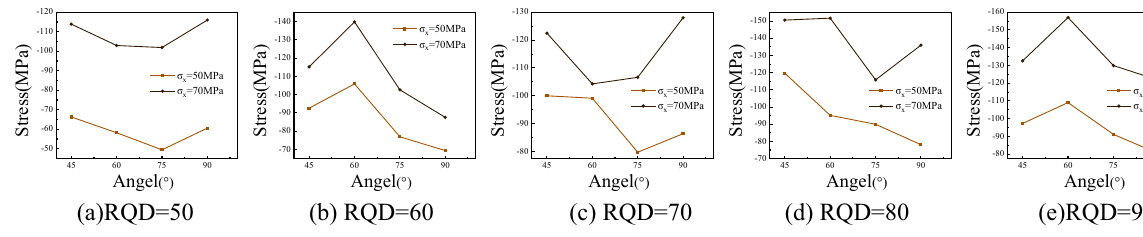
Fig. 35 Peak stress with different θ and in-situ stress values in the same